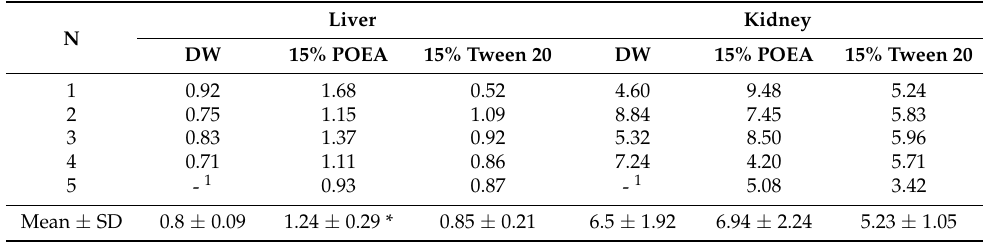
Table 3. Glyphosate concentrations ( µ g/mL) of liver and kidney in DW, 15% POEA and 15% Tween 20 groups in